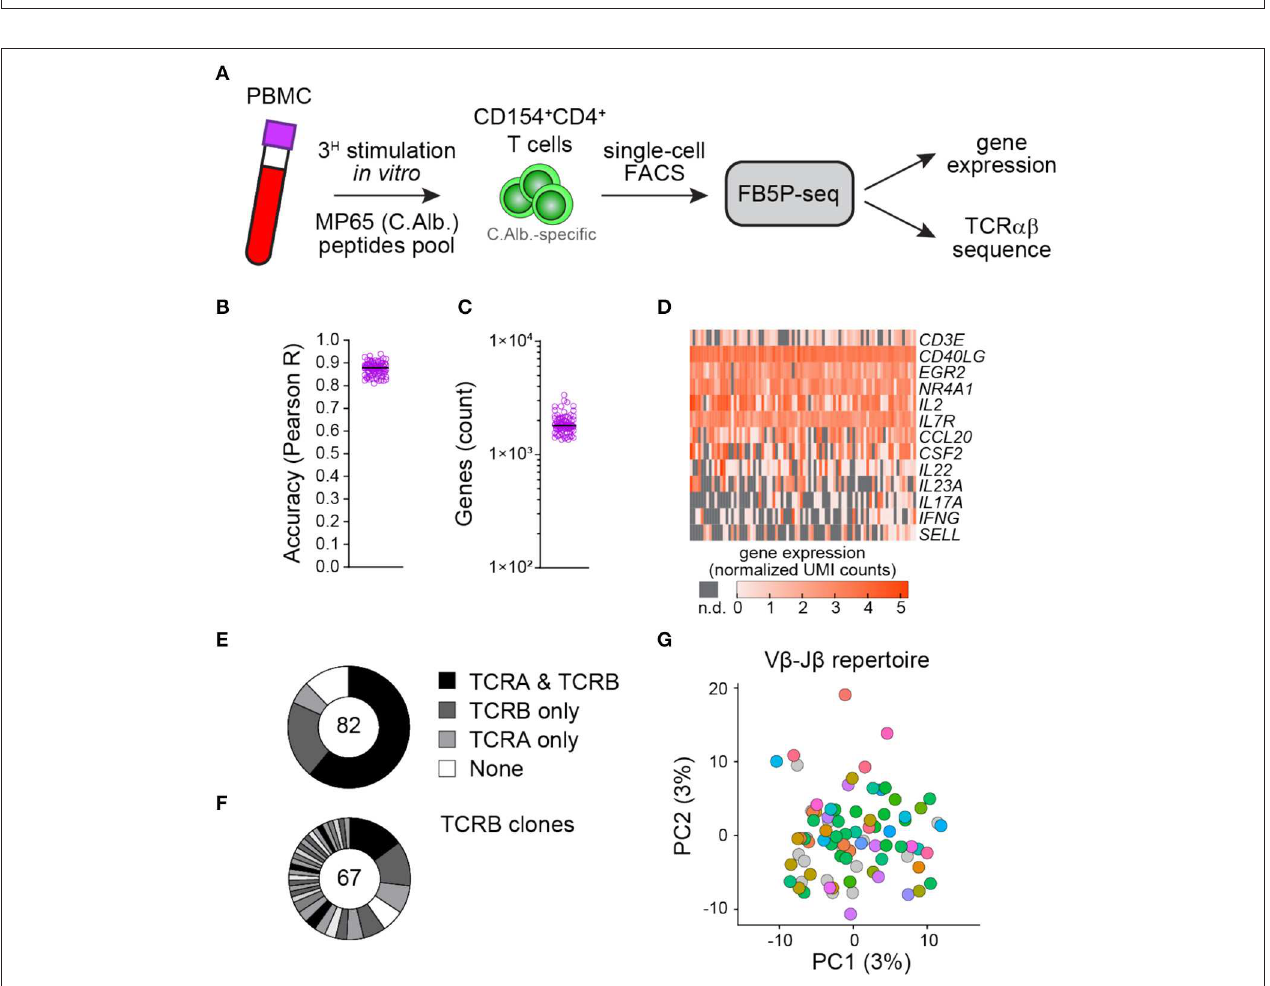
FIGURE 5 | FB5P-seq analysis of the human peripheral blood antigen-specific CD4T cells. (A) Experimental workflow for studying the human peripheral blood C. albicans -specific CD4T cells with FB5P-seq. (B) Per-cell quantitative accuracy of FB5P-seq computed based on ERCC spike-in mRNA detection (see section Materials and Methods) for C. albicans -specific CD4T cells ( n = 82). The black line indicates the median with 95% confidence interval error bars. (C) Total number of unique genes detected in C. albicans -specific CD4T cells ( n = 82). The black line indicates the median with 95% confidence interval error bars. (D) Gene expression heatmap of human peripheral blood C. albicans -specific CD4T cells for a selected panel of marker genes (n.d.: not detected). (E) Pie charts showing the relative proportion of cells with reconstructed productive TCRA and TCRB sequences (black), only TCRB sequences (dark gray), only TCRA sequences (light gray), or no TCR sequence (white) among C. albicans -specific CD4T cells ( n = 82). (F) Distribution of TCRB clones among C. albicans -specific CD4T cells ( n = 67). The black and gray sectors indicate the proportion of TCRB clones (clonotype expressed by at least two cells) within the single cells analyzed (white sector: unique clonotypes). (G) Projection of C. albicans -specific CD4T cells ( n = 82) on the first two PCs computed on 4,000 variable genes, excluding the TCR genes (PC1: 3% of total variability, PC2: 3% of total variability). The cells are colored based on the V β -J β repertoire (gray cells: no TCRB